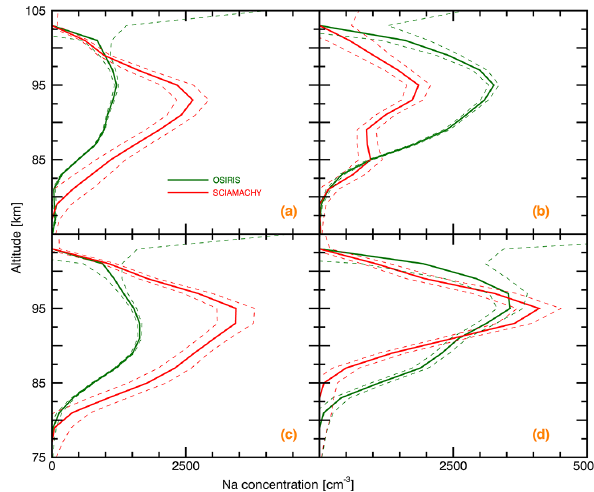
Figure 9. Sodium profiles retrieved from OSIRIS (green) and SCIAMACHY (red) mesospheric nighttime measurements for four months of the year 2008. (a) April 2008; (b) June 2008; (c) Octo- ber 2008; (d) December 2008. The dashed lines show the uncertain- ties corresponding to each